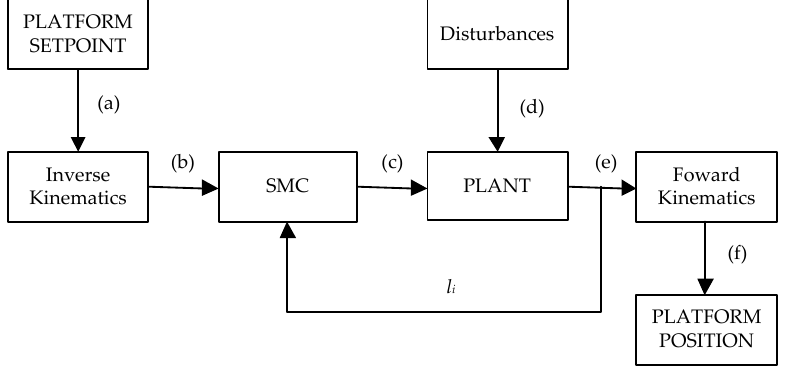
Figure 5. Stewart platform control scheme. The inverse and forward kinematics are used to calculate the actuator length for a determined platform position, and vice versa. The sliding mode control (SMC) generates the control action to bring the Stewart platform to the desired position.